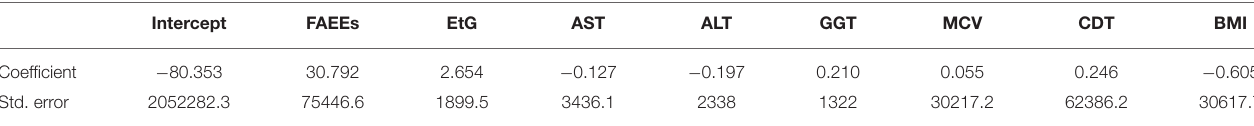
TABLE 3 | Logistic regression model coefficients and standard errors, estimated for the alcohol biomarkers dataset, using a logistic regression model implemented in the glm function in R . Intercept FAEEs EtG AST ALT